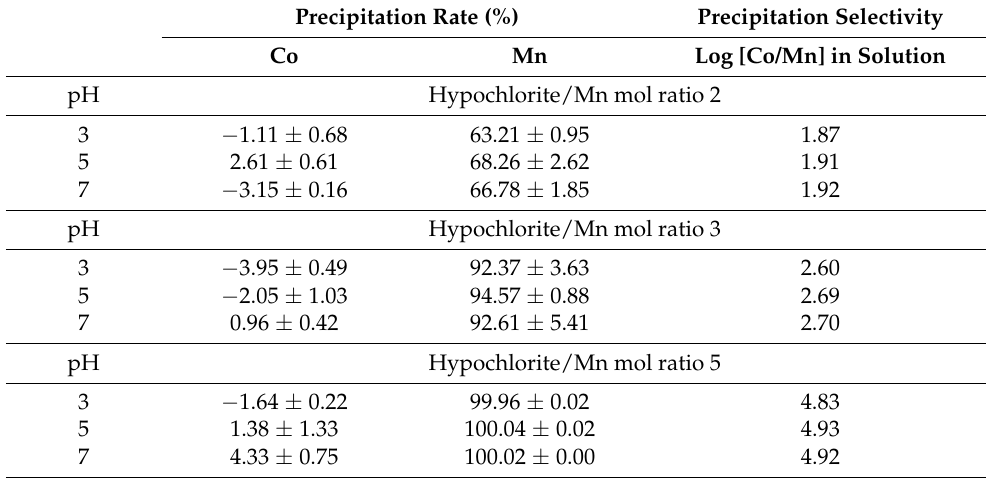
Table 8. The precipitation rate and selectivity of Co and Mn using sodium hypochlorite based on mol ratio of hypochlorite/Mn and initial pH of the strip